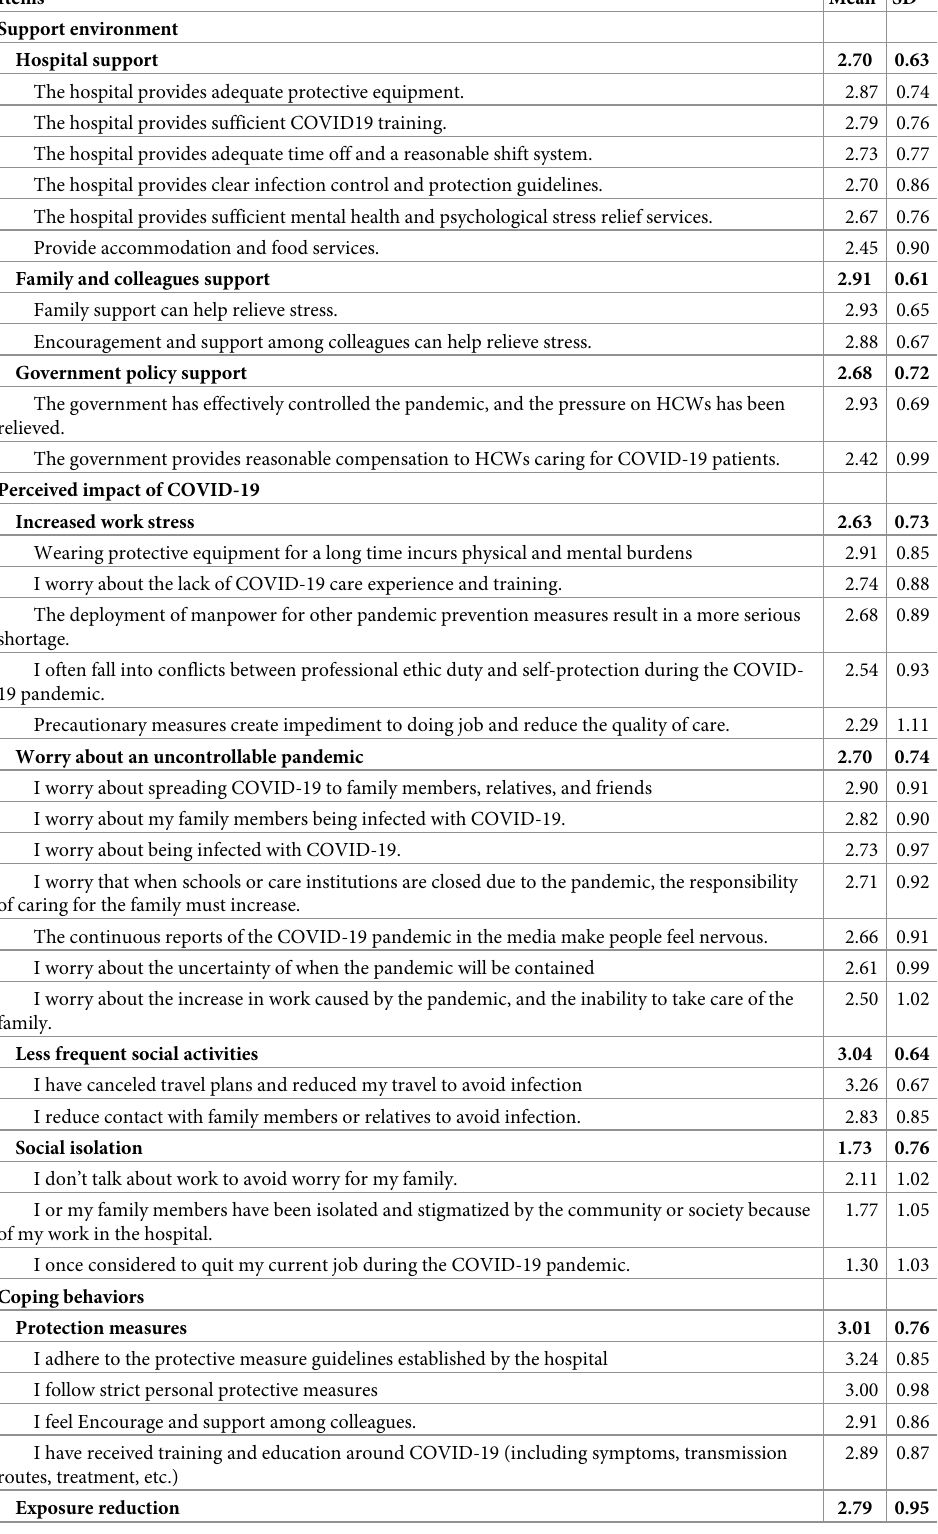
Table 2. The Descriptive statistics of support environment, perceived impact of COVID-19, coping